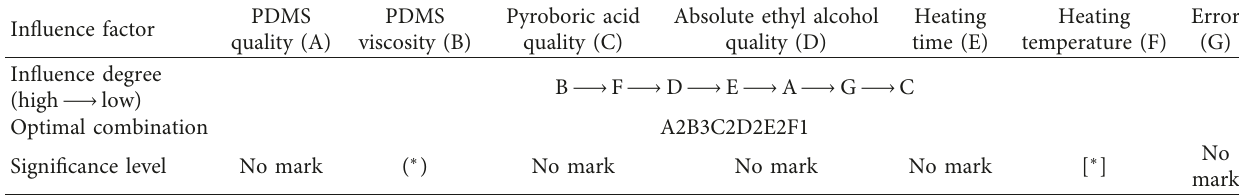
Table 4: The range analysis and variance analysis of the RSE.